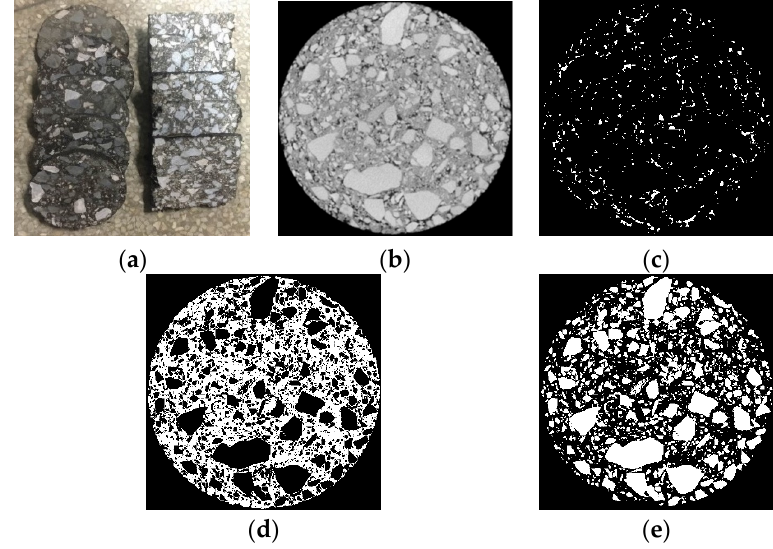
Figure 3. ( a ) Incised specimens; ( b ) graying process; ( c ) air voids; ( d ) mortar; ( e ) aggregates.